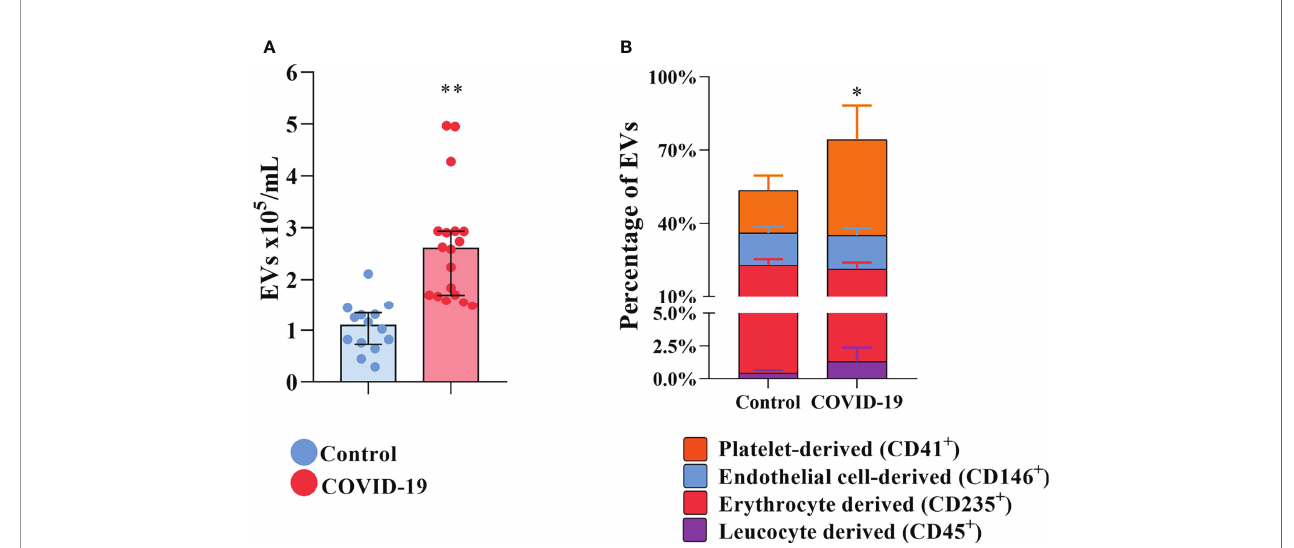
FIGURE 1 | Increased circulation of EVs in COVID-19 patients. (A) The total concentration of EVs found in the plasma of healthy donors and COVID-19 patients. (B) The distribution of the circulating EVs into its tissue of derivation. * indicates the difference between the percentage of platelet-derived EVs percentage when compared to healthy donors. Medians with interquartile range are shown. Individual values for healthy donors (blue dots) and COVID-19 patients (red dots) are shown. *p<0.05 and